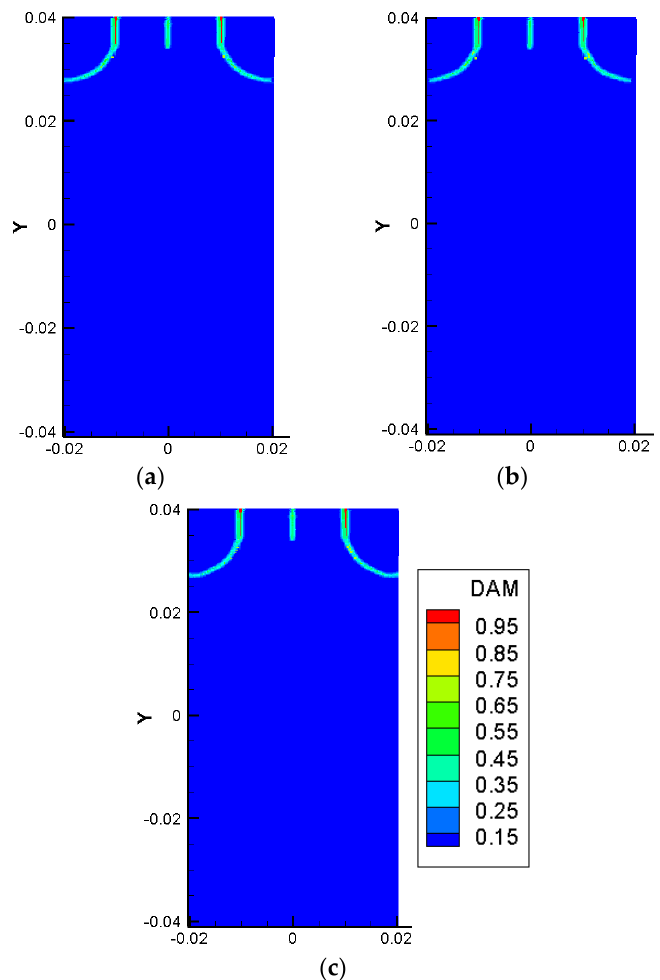
Figure 9. Crack propagation and deflection of an FGM coating substrate sample as a function of the different gradient parameters under a dynamic concentrated load: ( a ) linear function; ( b ) exponential function; ( c ) sine function.